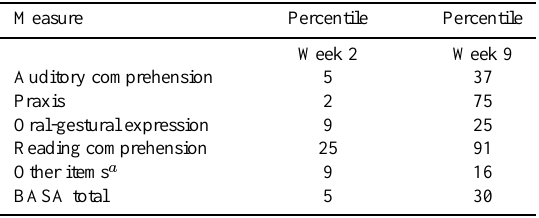
Table 2 Boston assessment of severe aphasia, case